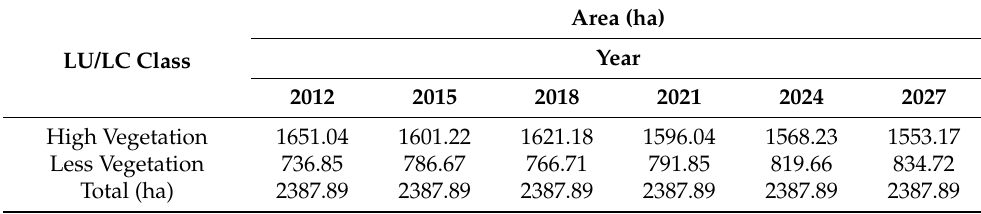
Table 9. LU/LC area statistics for LU/LC Map